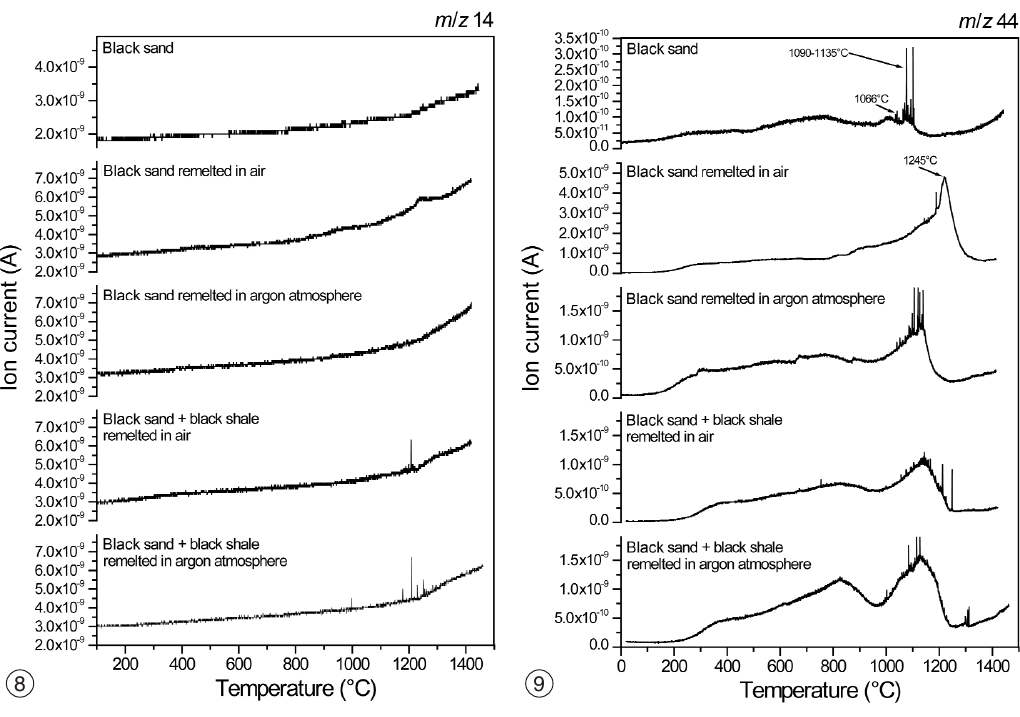
Fig. 8. Change of the partial pressure of the mass number m / z = 14. Fig. 9. CO 2 release of black sand and remelting